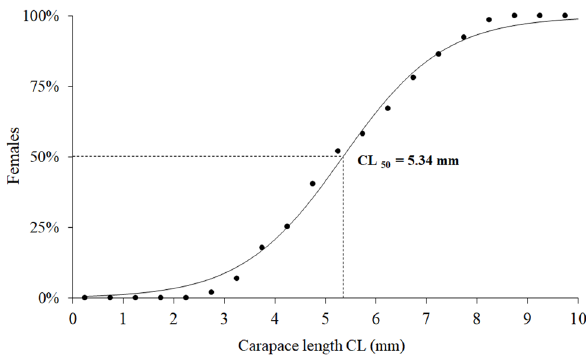
Figure 5. Alpheus brasileiro Anker, 2012. Logistic curve interpolation where 50% of females reach functional sexual maturity (CL 50